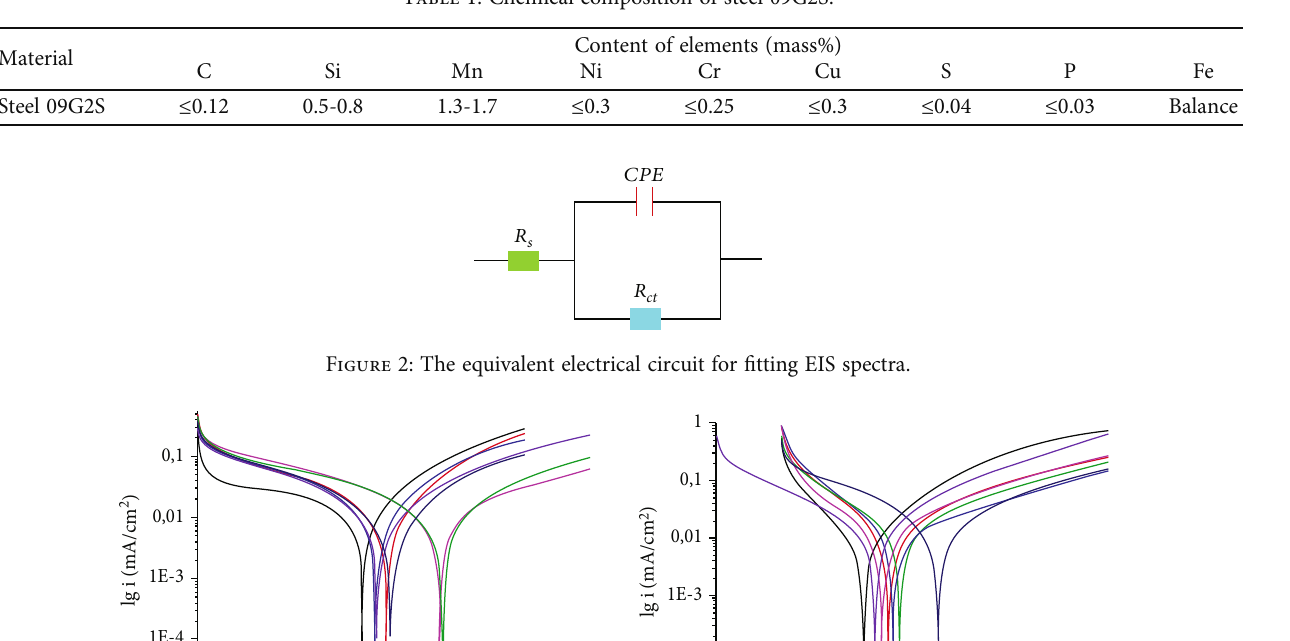
Table 1: Chemical composition of steel 09G2S.